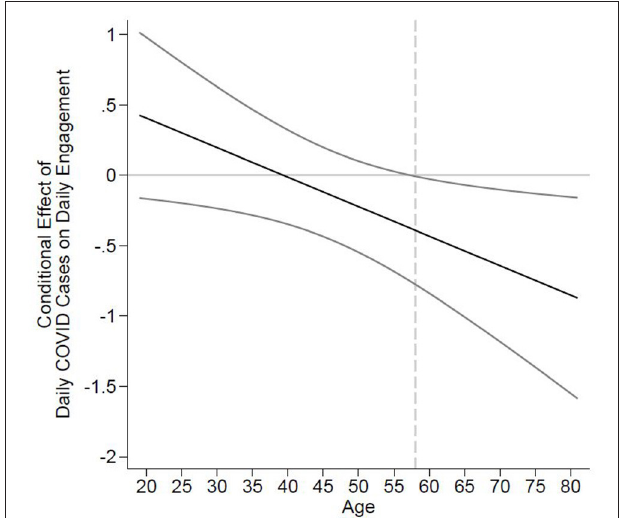
FIGURE 2 | Johnson–Neyman regions of significance for the conditional relation between daily COVID-19 cases and daily engagement at realized values of chronological age. The black line depicts the conditional effect of daily COVID-19 cases on daily engagement ( y- axis) dependent on the value of the age moderator ( x- axis). The curved lines are the 95% confidence intervals of the conditional effect. The dashed vertical line represents the point at which the confidence interval does not include zero marking the region of significance of the conditional effect.